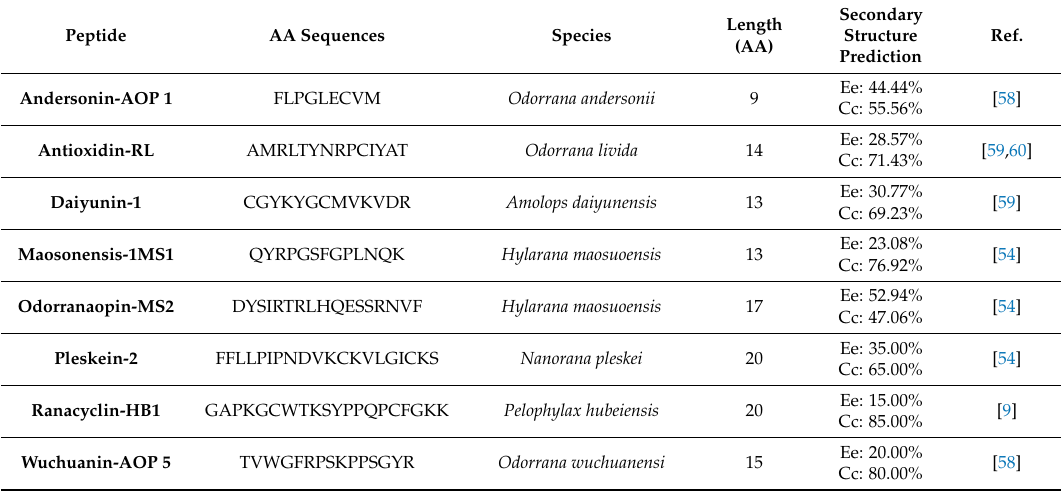
Table 3. Amphibian peptides relevant for skin protection from UV light. Secondary structure prediction was performed by the GOR IV algorithm